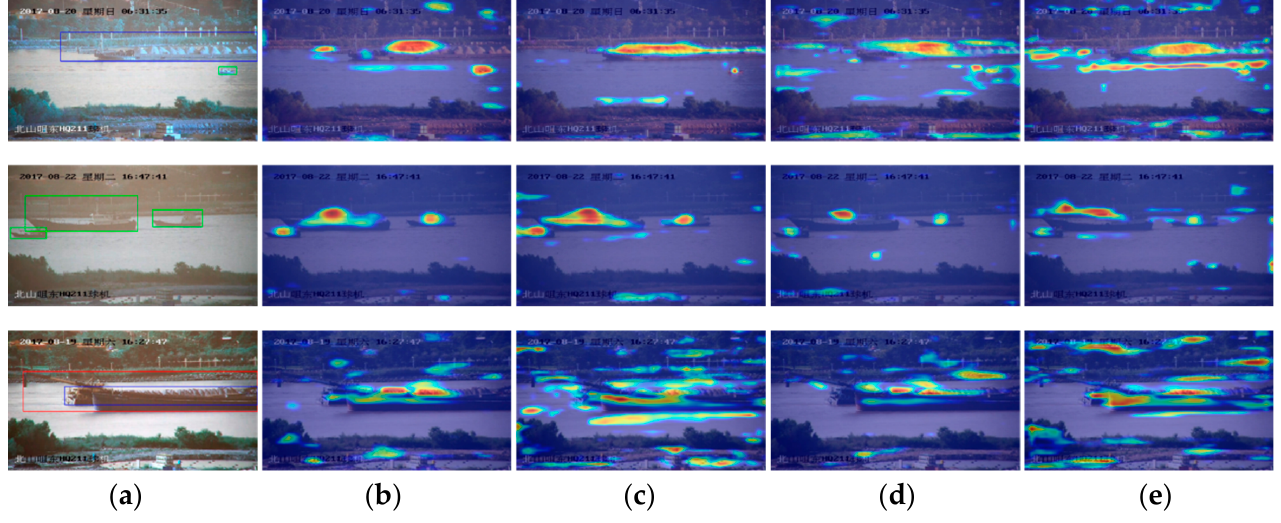
Figure 6. Grad-CAM renderings under three conditions; ( a ) original drawing; ( b ) C1; ( c ) C2; ( d ) C3; ( e ) not embedded.